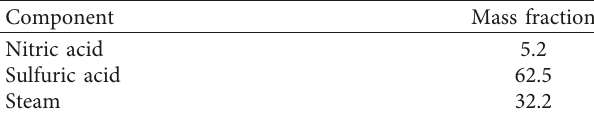
Table 1: Composition of the mixer output